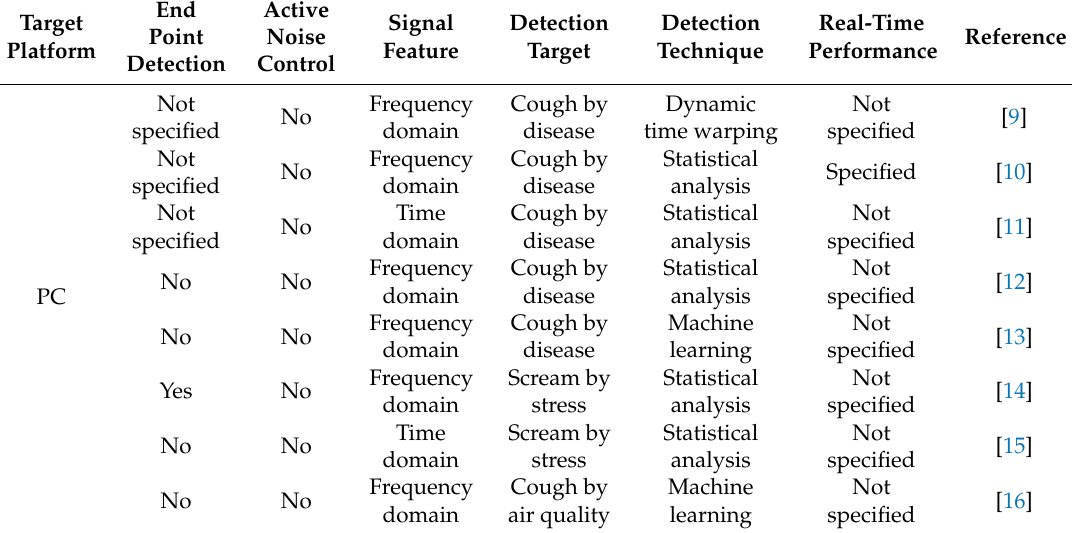
Table 1. Some of the recent pigs’ abnormality detection research (published between